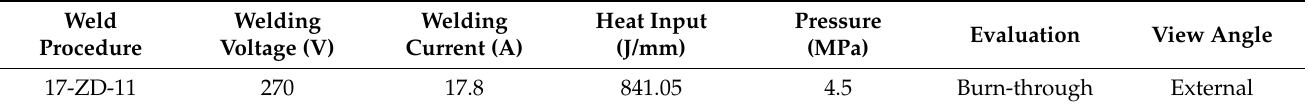
Table 7. Axial in-service welding parameters.